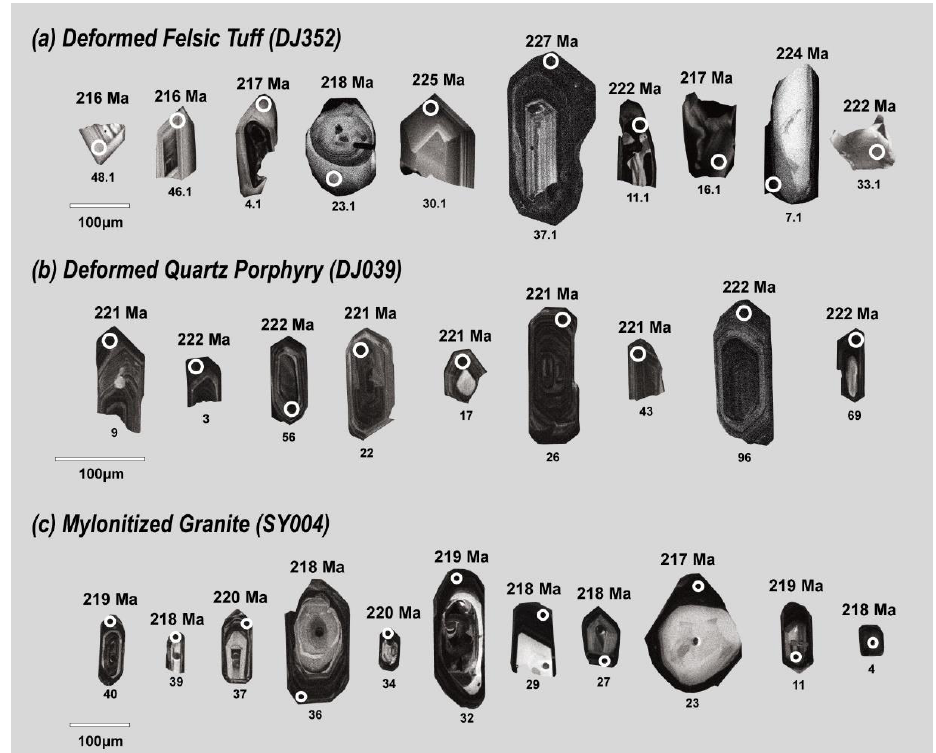
Figure 9. Scanning electron microscope cathodoluminescence (CL) images of sectioned zircon grains from ( a ) a deformed felsic tuff, ( b ) deformed quartz porphyry, and ( c ) mylonitized porphyritic granite.